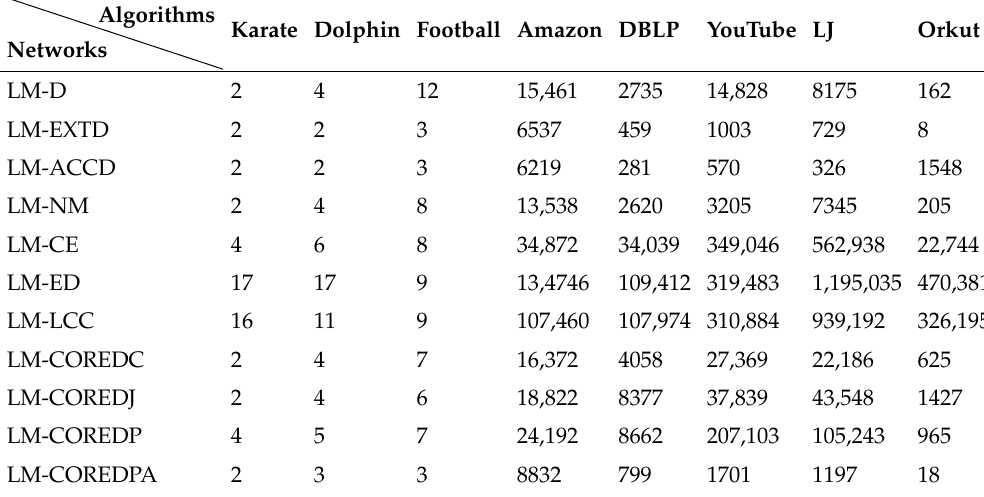
Table 4. The number of seeds (with the fraction in parentheses for large-scale networks) chosen by different algorithms.